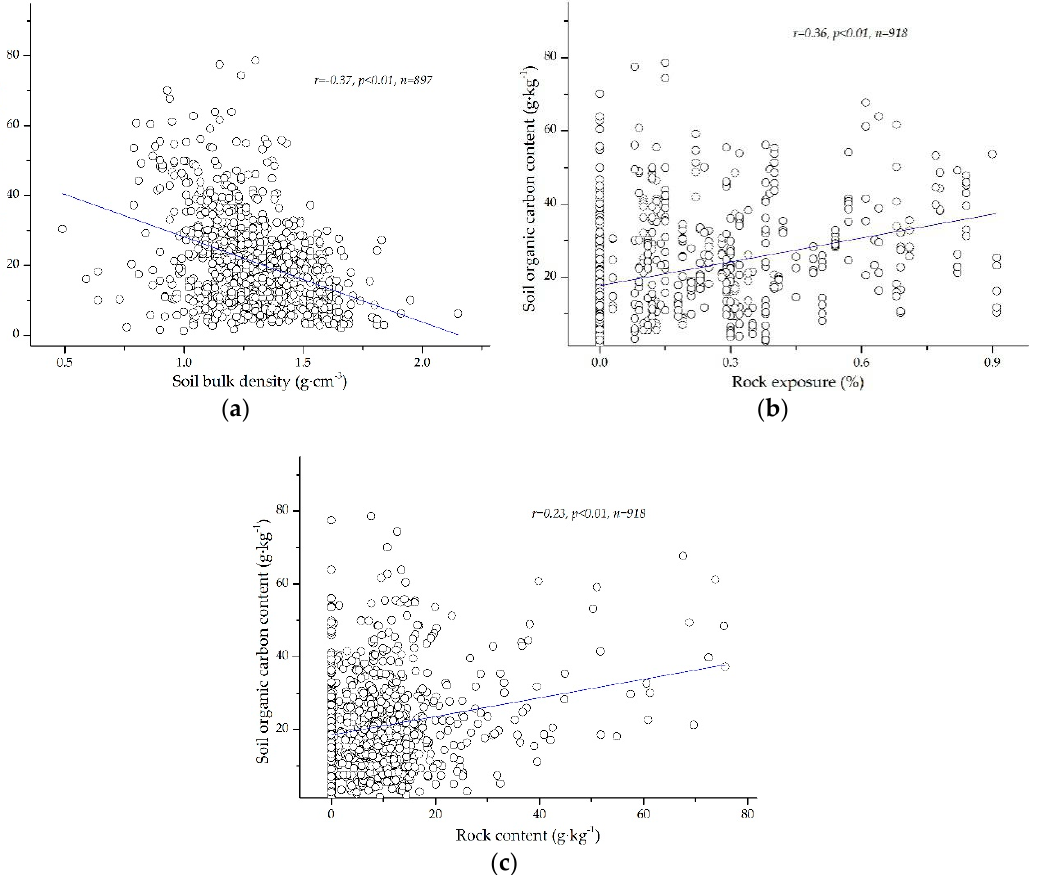
Figure 4. The correlations among soil organic carbon (SOC) content and soil bulk density (SBD), rock exposure and rock content: ( a ), ( b ) and ( c ) represent the correlation among the SOC and SBD, rock exposure and rock content, respectively.